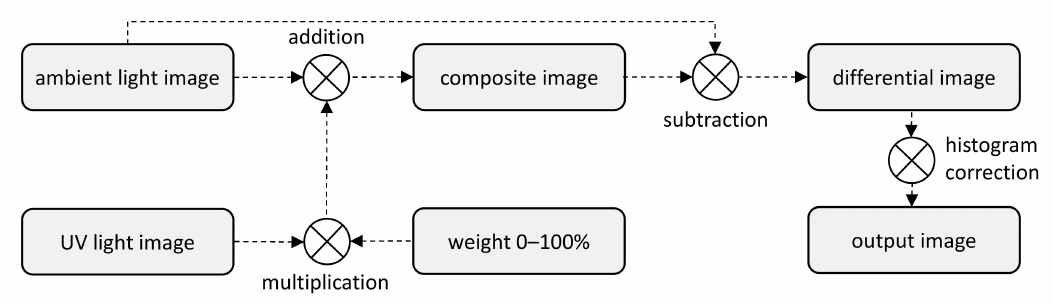
Figure 3. Setup of static experiments using ambient light images and UV light images (adapted from [3]).